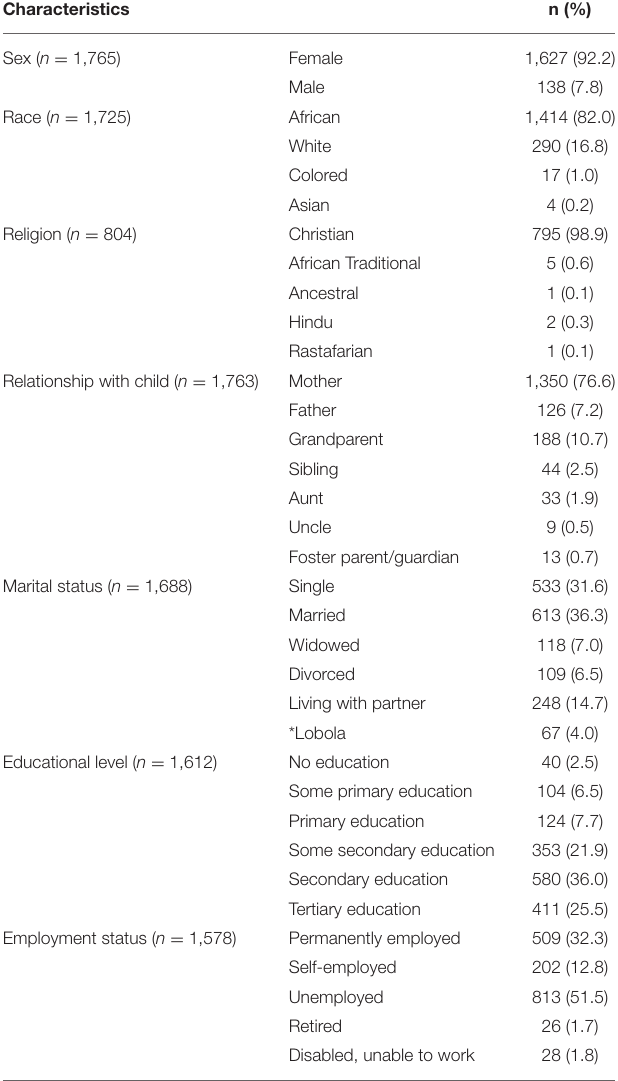
TABLE 1 | Frequency distributions of socio-demographics of